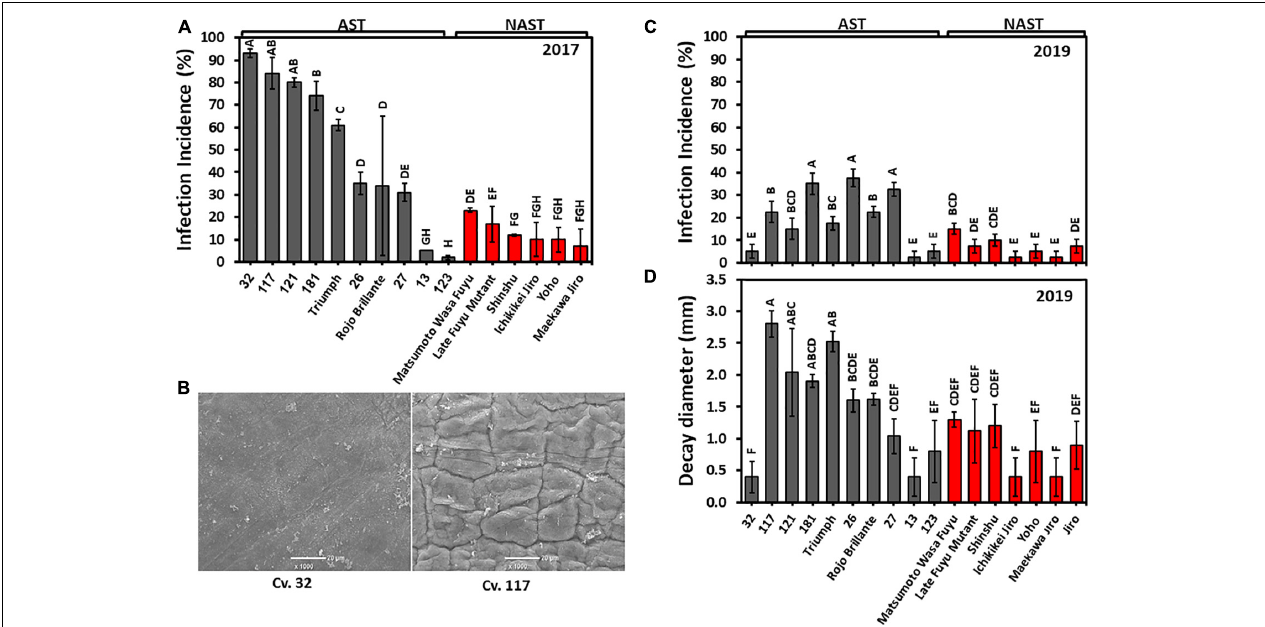
FIGURE 8 | Alternaria infection in the different persimmon cultivars in pierced fruit (2017) and non-pierced fruit (2019). (A) Infection incidence on pierced fruit for harvest 2017. (B) Fruit surface analysis by SEM of Cvs. “32” and “117.” (C) Infection incidence on non-pierced fruit for harvest 2019. (D) Decay diameter in non-pierced fruit for harvest 2019. Bars show the average of 5 fruits at 8 places; ± SE. Different letters indicate a significant difference between treatments according to the Tukey-Kramer HSD test at p ≤ 0.05.